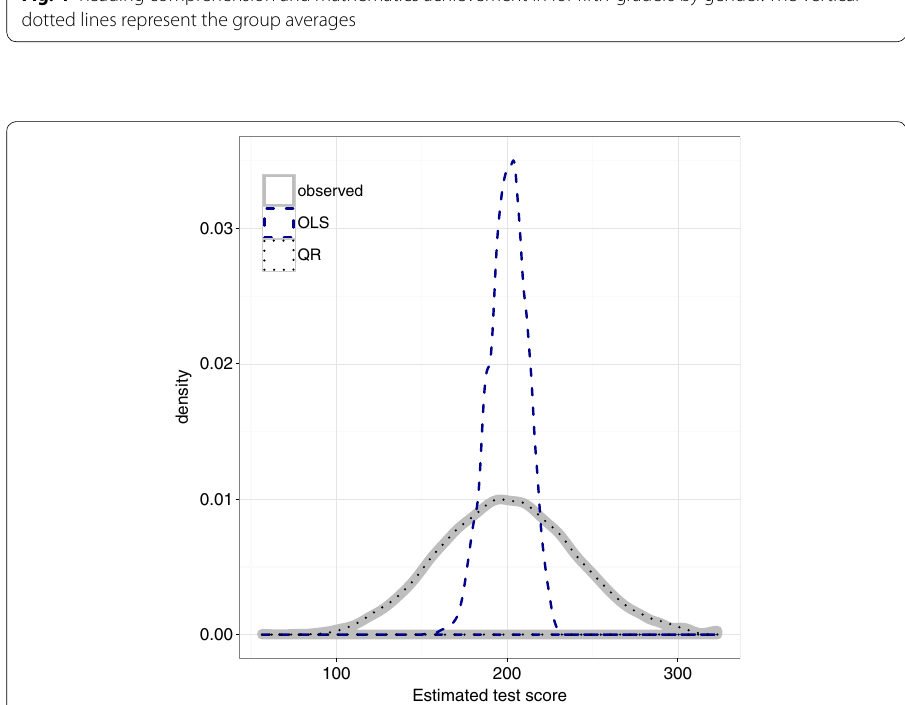
Fig. 5 Distribution of observed students’ performances in mathematics (straight line) and of the estimated performances distribution using LS (dashed line) and QR approach (dotted